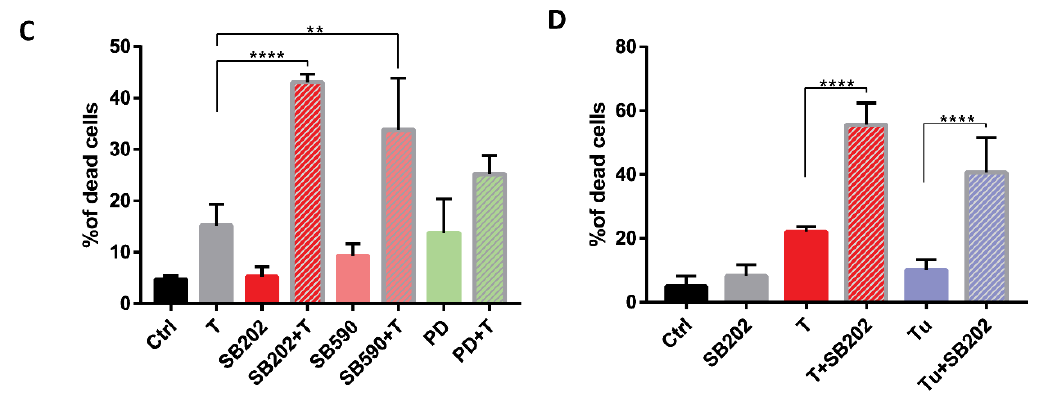
Figure 7. Pyridinyl imidazole compounds sensitize human melanoma cells to endoplasmic reticulum (ER) stress. Propidium iodide-based flow cytometry analysis of cell viability treated with small molecule compounds for 48 h. Presented data were obtained in three independent experiments. ( A ) Viability of BRAF-mutated A375 cells treated with SB202190 (SB; 5, 10, and 15 μM) in combination with ER stressor thapsigargin (T; 50 and 100 nM). ( B ) Viability of NRAS-mutated MEL-JUSO melanoma cells treated with SB202190 (SB; 5, 10, and 15 μM) in combination with thapsigargin (T; 50 and 100 nM). ( C ) Viability of A375 cells treated with thapsigargin (T; 50 nM) together with pyridinyl imidazole inhibitors SB202190 (SB202; 15 μM) and SB590885 (SB590; 5 μM), and MEK inhibitor PD184352 (PD; 0.5 μM). ( D ) Viability of A375 cells treated with SB202190 (SB202; 15 μM) in combination with ER stress inducers thapsigargin (T; 50 nM) and tunicamycin (Tu; 0.5 μM). ** denotes p < 0.01, **** indicates p < 0.0001